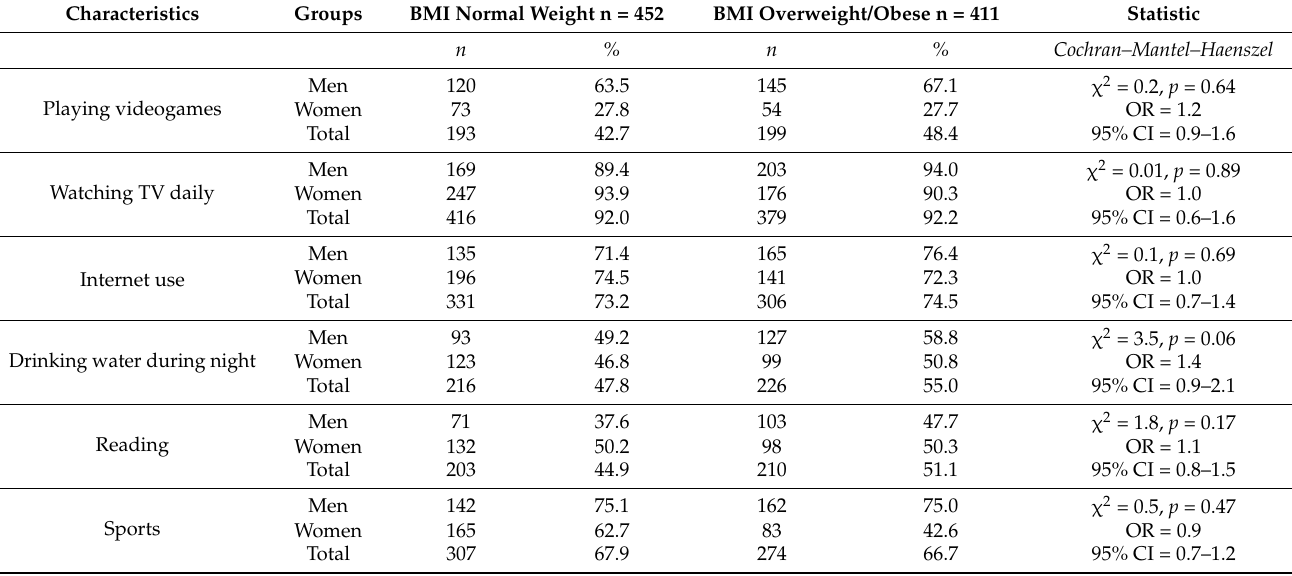
Table 1. Sleep variables, as well as sedentary and physical activities, among BMI groups according to sex.